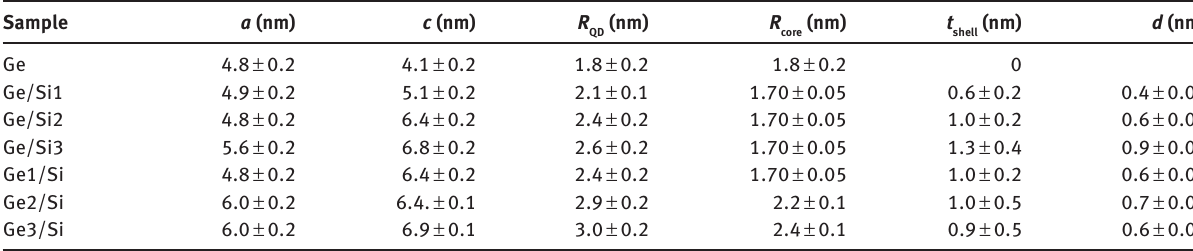
Table 2: QD size determined from GISAXS. Sample